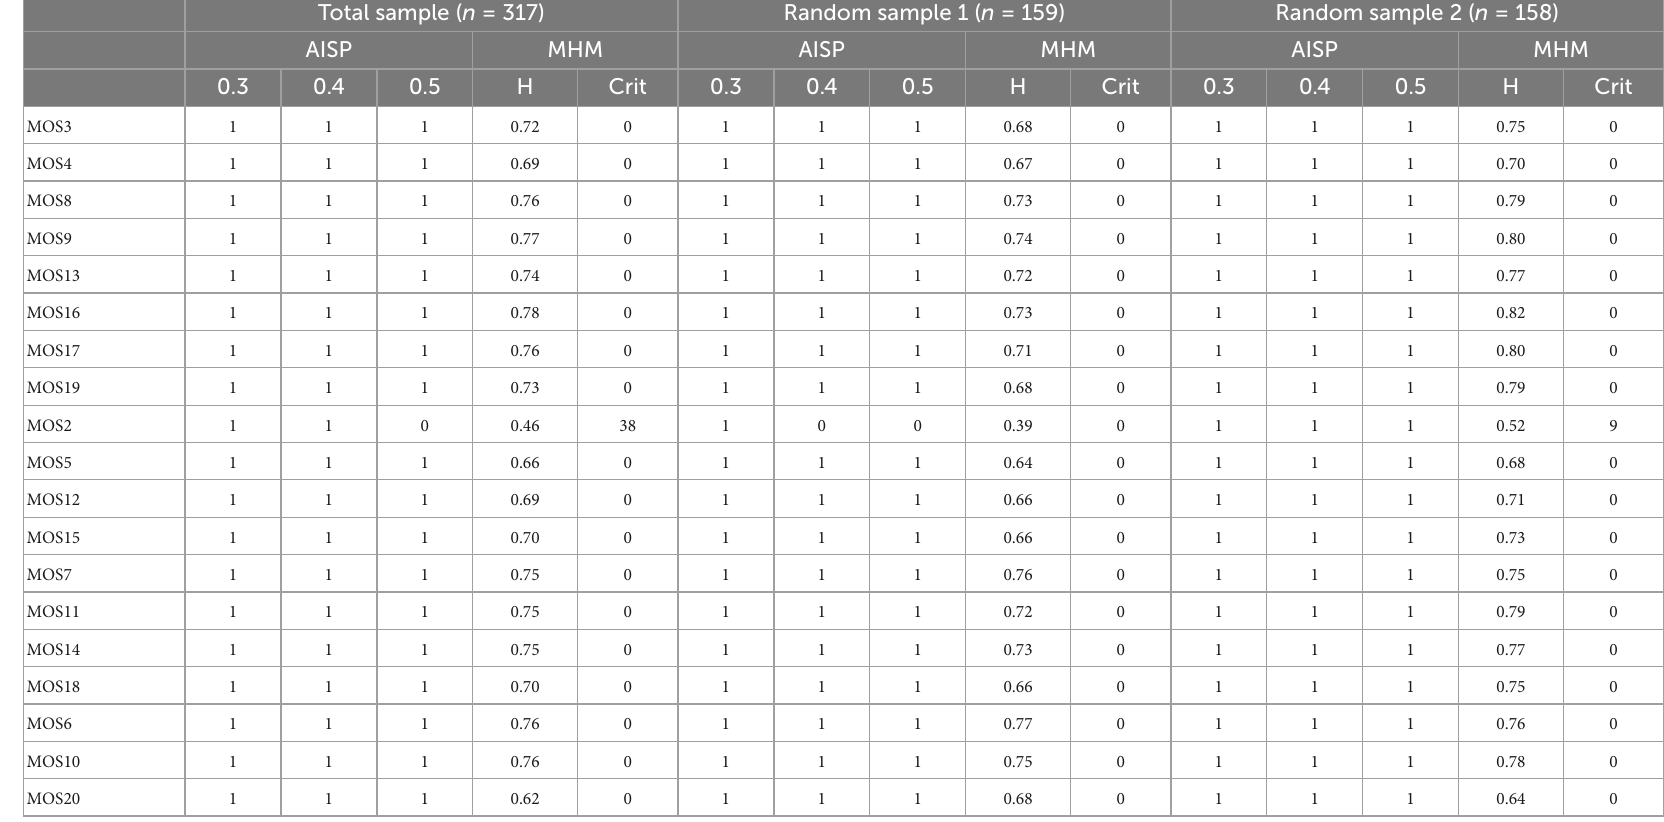
TABLE 4 MSA: Number of dimensions (AISP) and monotonic homogeneity model